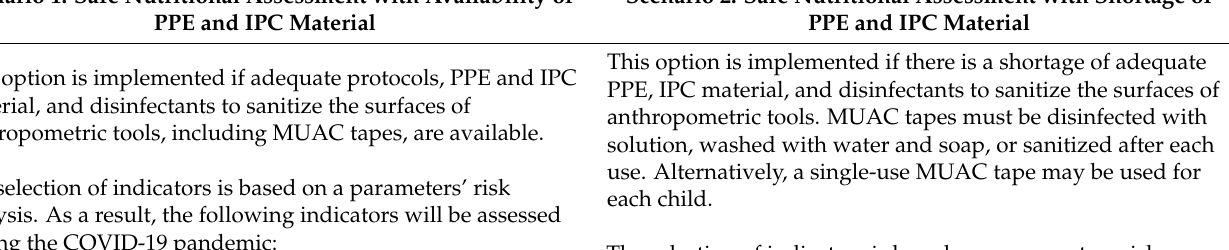
Table 5. Two possible scenarios for nutritional assessment, based on the availability of PPE and IPC material. Scenario 1: Safe Nutritional Assessment with Availability